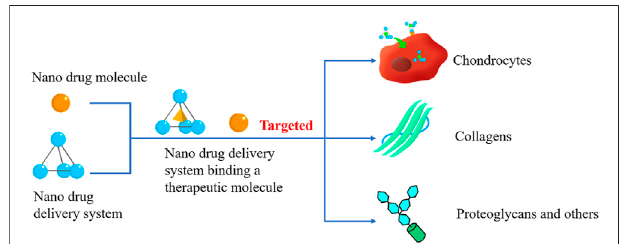
FIGURE 2 | Cartilage Targeted nanodrugs. Cartilage-Targeted nanodrugs can be divided into nano therapeutical molecules and nano-drug delivery systems (DDSs). Both of them can speci fi cally react with the components of cartilage, mediating the OA treatment